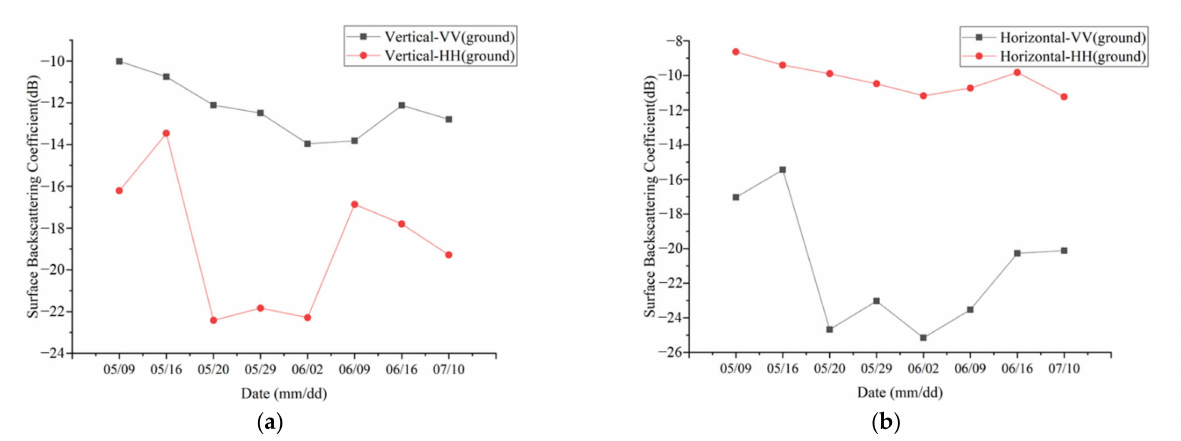
Figure 7. Mean value of surface backscatter obtained by polarization decomposition ( a ) Vertical volume scattering matrix; ( b ) Horizontal volume scattering